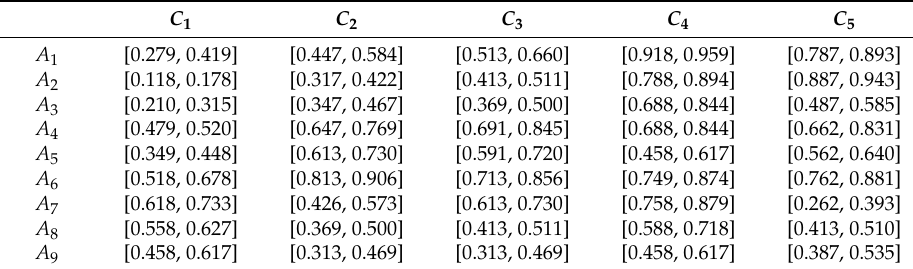
Table 4. Approach-index matrix after aggregation.